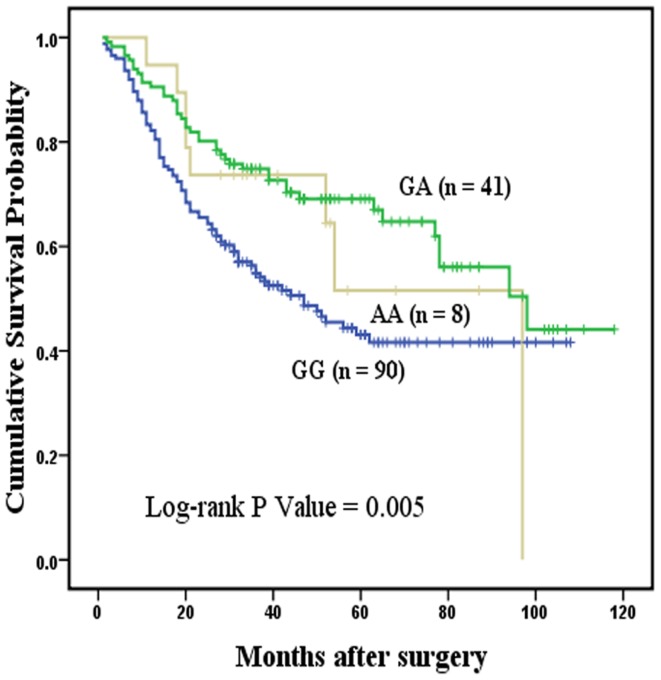
Overall survival curve in relation to MYT1L rs17039396 polymorphism in patients with cardia gastric cancer in overall model.
Figure 1 represents the Kaplan-Meier survival curve in relation to the effect of MYT1L variants on overall survival of the patients with cardia gastric cancer in overall model and the P value of log-rank test received statistical significance.